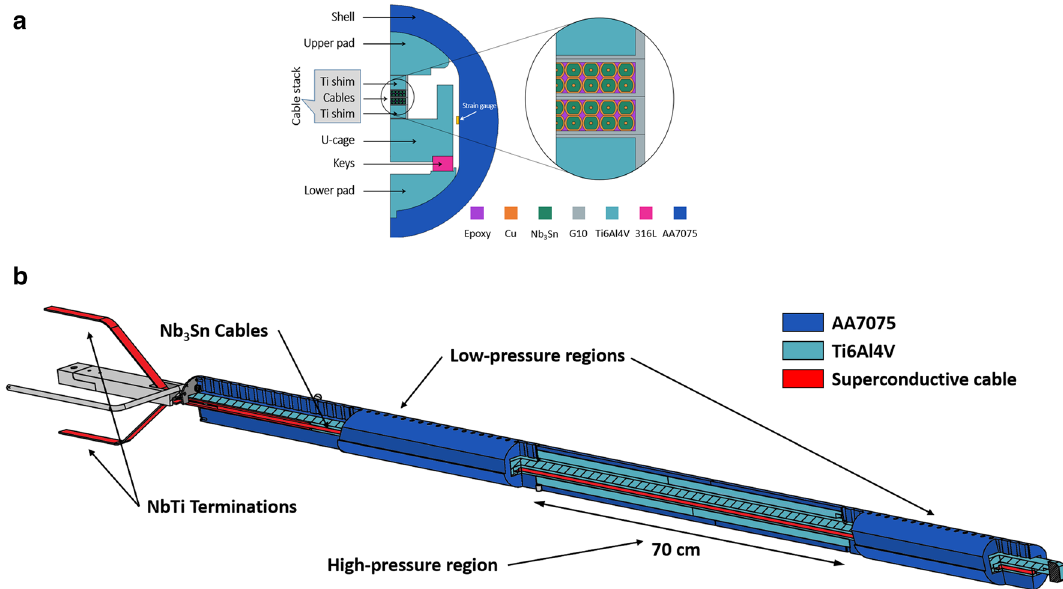
Figure 6. The FReSCa sample holder for critical current measurements of long cables under transversal load. The high-pressure region extends over 700 mm field uniformity length, and it is representative of the pressure that the conductor experiences in a real accelerator magnet. Top: cross-section of the high-pressure region, showing the stainless keys used to create mechanical interference; bottom: an axonometric projection of the entire assembly.